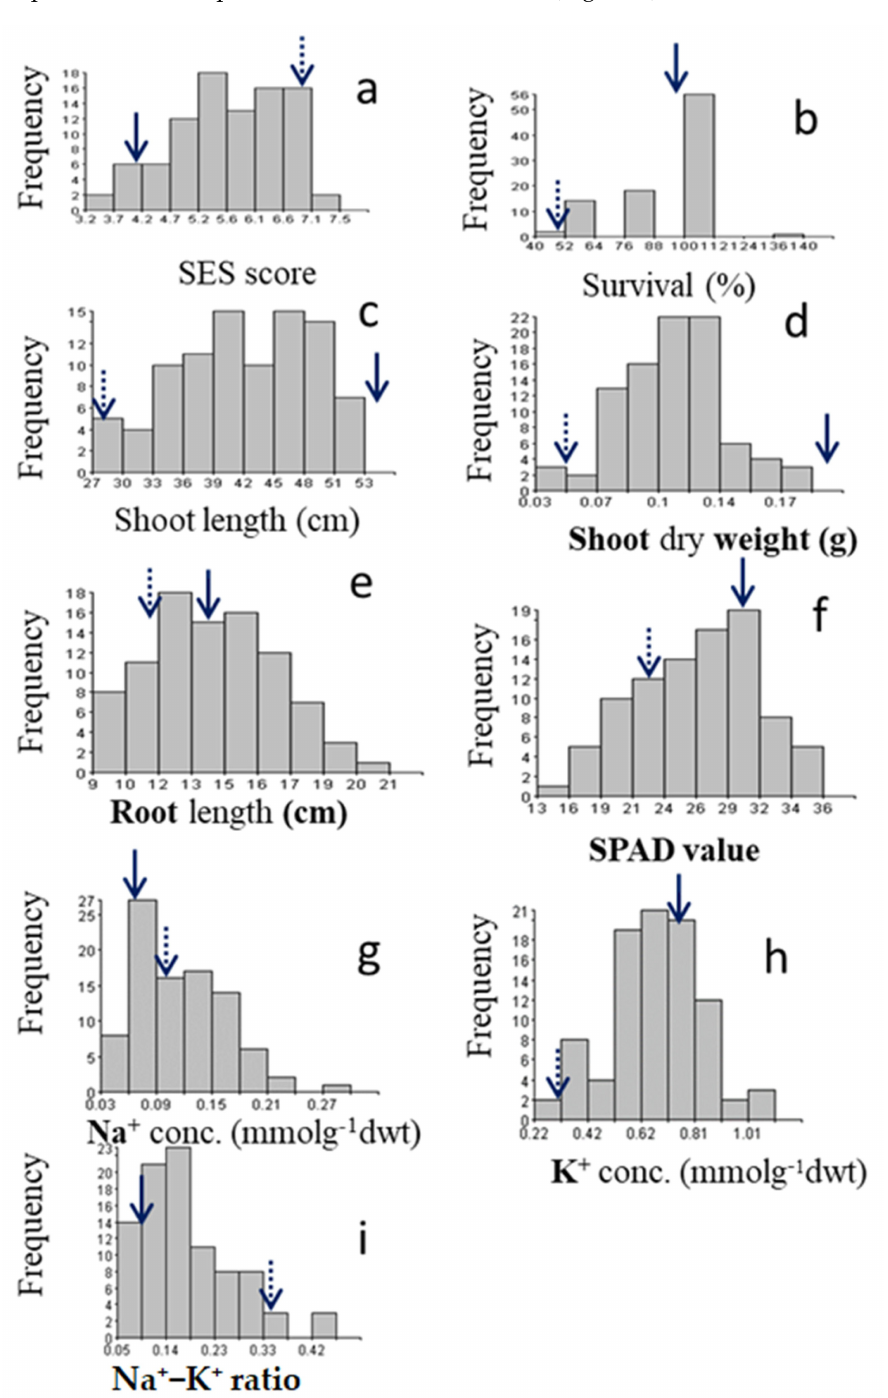
Figure 1. Histogram illustrates the distribution (number of plants) of the F 2:3 individuals for traits associated with salinity tolerance at the seedling stage: ( a ) SES score, ( b ) survival rate, ( c ) shoot length, ( d ) shoot dry weight, ( e ) root length, ( f ) SPAD value, ( g ) Na conc. ( h ) K conc. ( i ) Na/K ratio. Solid and dotted arrows indicate the phenotypic value of the tolerant parent Akundi and sensitive BR49,